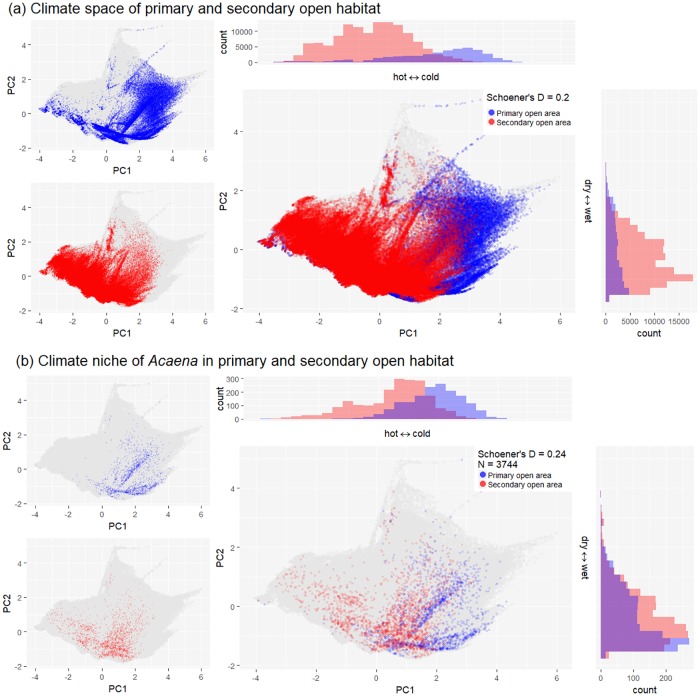
Climate space of primary and secondary open habitat and niches of Acaena species in primary and secondary open habitat.(a) Climate space of primary (blue) and secondary (red) open habitat and (b) currently occupied niches of Acaena species in primary and secondary open habitat are shown. In the figure (a), Schoener’s D values indicate the overlap in climate conditions between primary and secondary open habitat (0 = no overlap; 1 = full overlap). In the figure (b), Schoener’s D values indicate the climatic overlap between species’ occurrence records in primary and secondary open areas. “N” is the total number of 1 km grid cells with Acaena occurrences. Figures show the first two axes of a Principal Component Analysis of four climate variables (see Methods) at 1 km grid resolution. The total climate space of New Zealand is shown in dark grey.